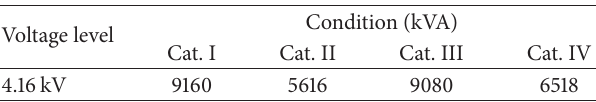
Table 3: Apparent power rating (kVA) loading summary of Class 1E system.